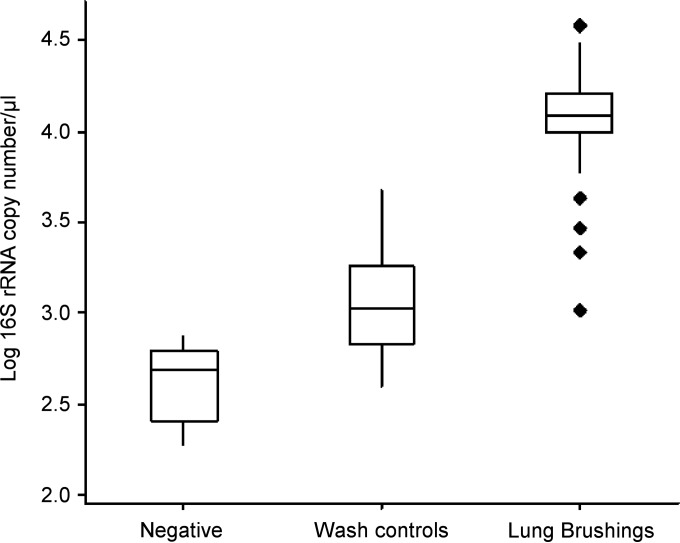
qPCR of lung brushing and control specimens. The bronchoscope channel was flushed with 7.5 ml of PBS, and the wash was collected (wash control, n = 18) prior to protected specimen brushing being performed on the lungs of sheep (lung brushings, n = 54). DNA was extracted from wash control and lung brushing specimens, and the quantity of bacterial DNA was calculated using 16S rRNA gene qPCR. Lung brushing specimens were found to contain significantly higher quantities of bacterial DNA than did wash controls (Mann-Whitney U test, P < 0.0001). Negative controls consisted of either water (n = 3) or extraction kit (n = 2) controls. Boxes, interquartile ranges; diamonds, outliers.